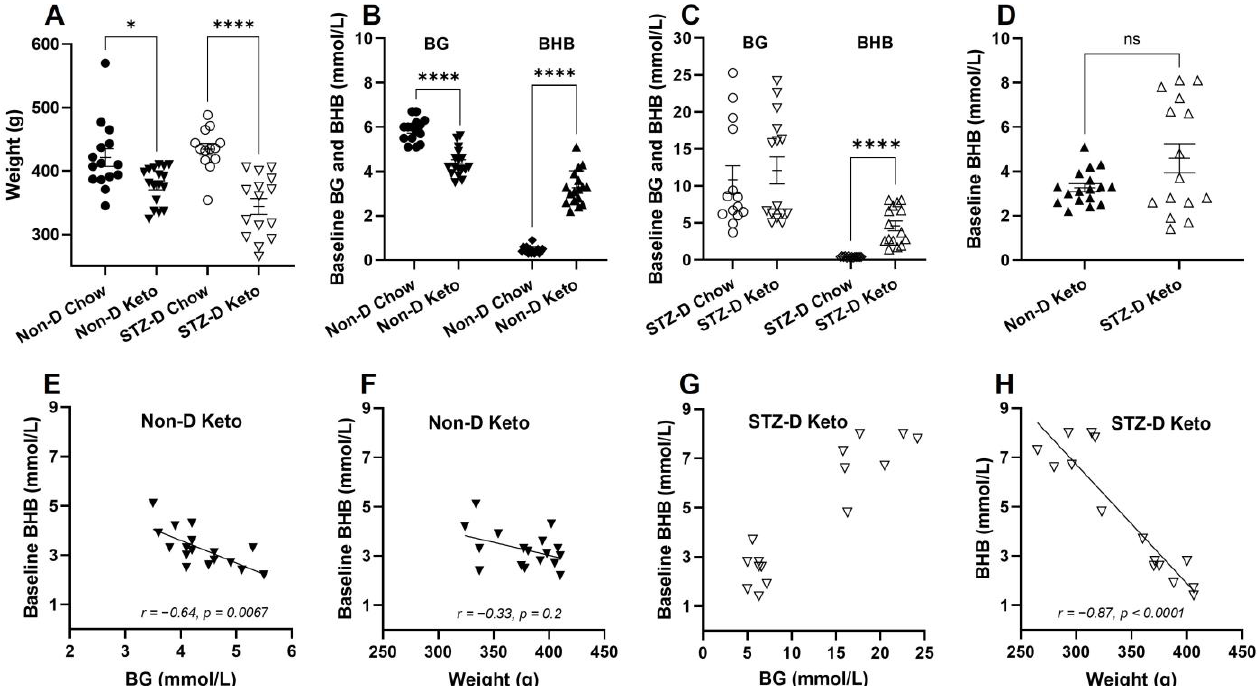
Figure 1. The effects of three weeks of nutritional ketosis of bodyweight, blood glucose (BG) and β-hydroxybutyrate (BHB) of non-diabetic and STZ-diabetic rats. Diabetes was induced with a single i.p. injection of 60 mg/kg STZ (citrate buffer was used in non-diabetic controls), followed by 3 weeks of dietary intervention. ( A ) Significantly lower bodyweight in ketogenic diet-fed non-diabetic (Non-D Keto) and diabetic (STZ-D Keto) rats compared to respective chow-fed controls; ( B ) Non-D Keto rats had lower BG and higher BHB concentrations than chow fed controls; ( C ) Keto diet did not affect BG in STZ-diabetic rats, but significantly elevated BHB; ( D ) No differences in baseline BHB of Non-D Keto and STZ-D Keto rats were observed; ( E ) Baseline BHB inversely correlated with BG in Non-D Keto rats; ( F ) BHB did not significantly correlate with weight in Non-D Keto rats; ( G ) Highest BHB concentrations in STZ-D Keto rats corresponded to the highest BG; ( H ) A strong inverse correlation between bodyweight and BHB was detected in STZ-D Keto rats. Data